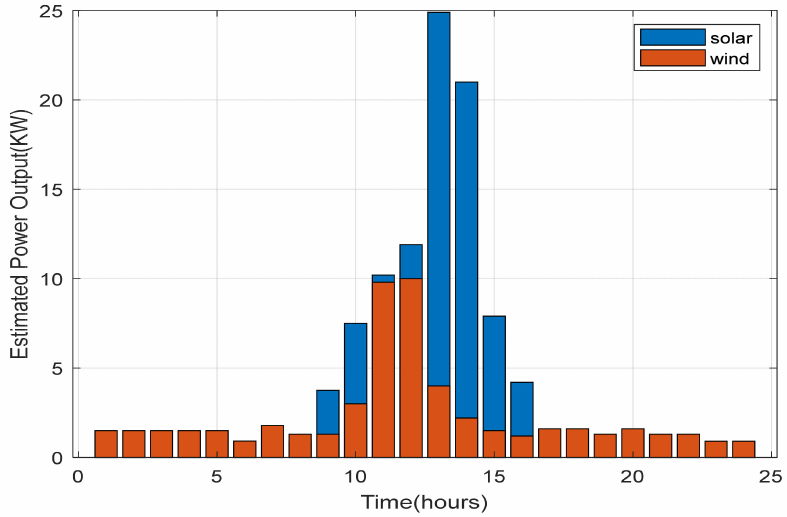
Figure 8. Output power forecast from Photo Voltaic (PV) and wind turbine